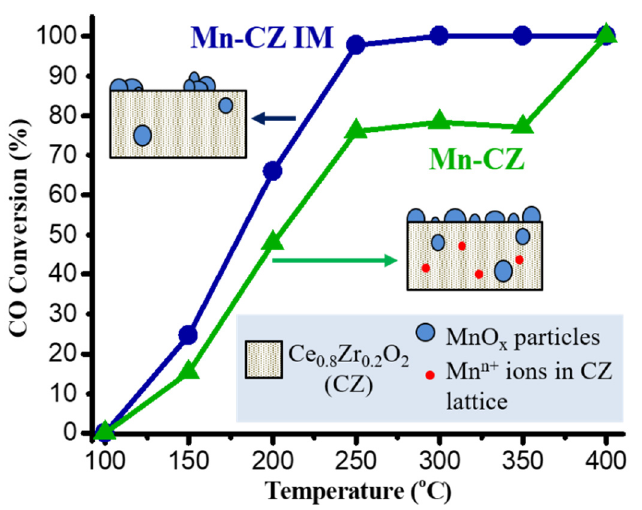
Figure 3. CO oxidation over Mn-CZ prepared by one-pot EISA method using CTAB template, and Mn-CZ IM, where MnO x was supported on CZ by impregnation (adapted from [31]).